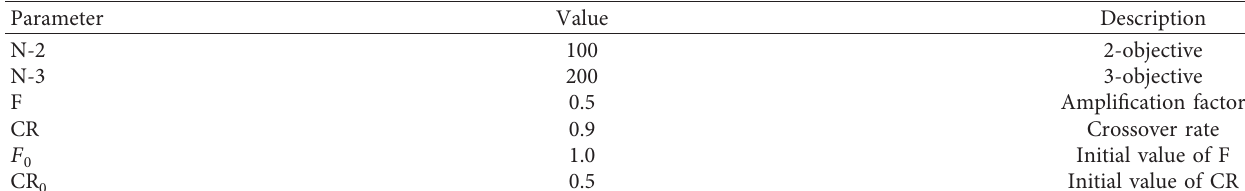
Table 1: The settings of